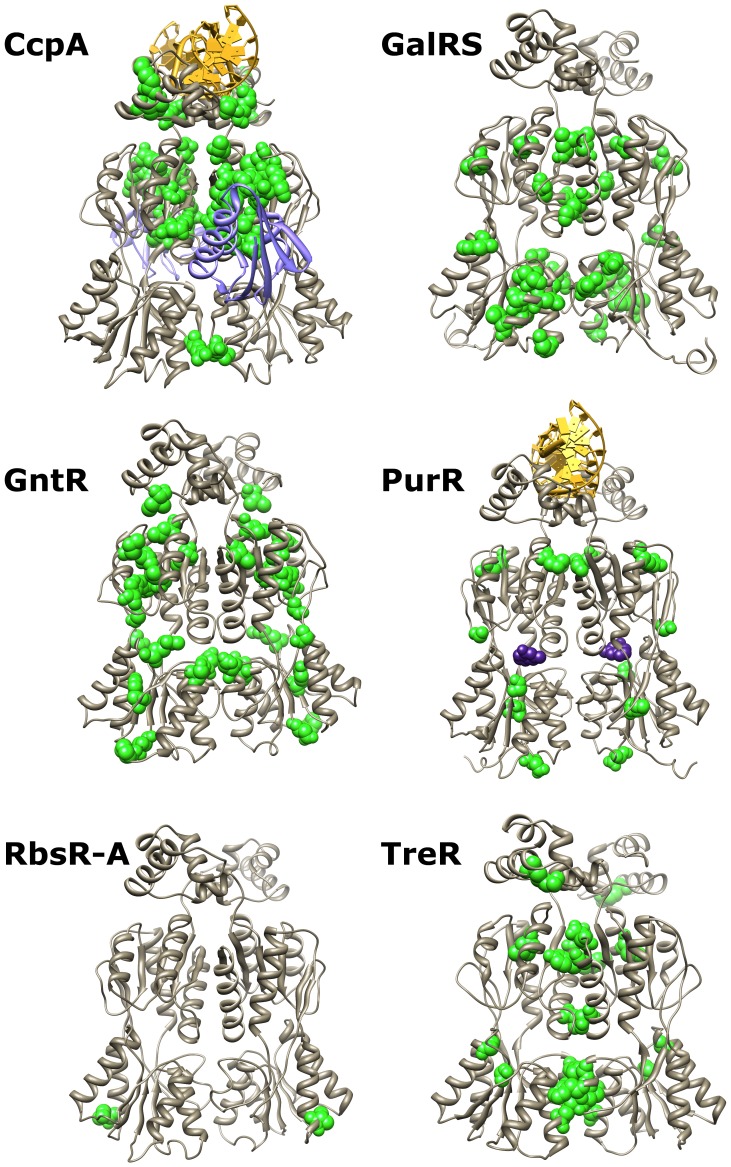
Structural context of subfamily-specific conserved sites.Subfamily-specific conserved positions are shown in green and space-filling on their respective crystallographic or modeled structures. The DNA operator (yellow) is shown bound to CcpA and PurR; an allosteric effector is shown bound to PurR (purple spacefilling); phosphorylated HPr (purple ribbon) is shown bound to CcpA. Allosteric effector binding in the cleft between N- and C-regulatory subdomains is common to all six subfamilies, while HPr-Ser46-P interacts only with CcpA. Molecular graphics were created in UCSF Chimera 1.6.2 [33].